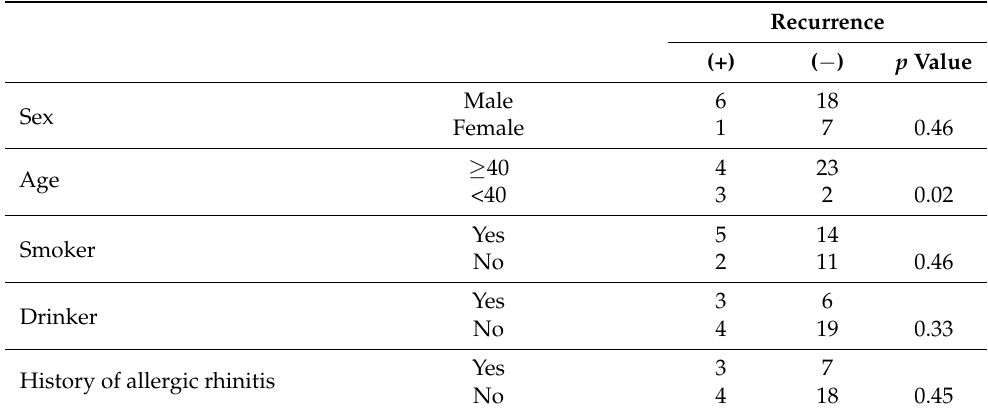
Table 1. Association between Recurrence and Clinical Characteristics in Patients with Sinonasal Inverted